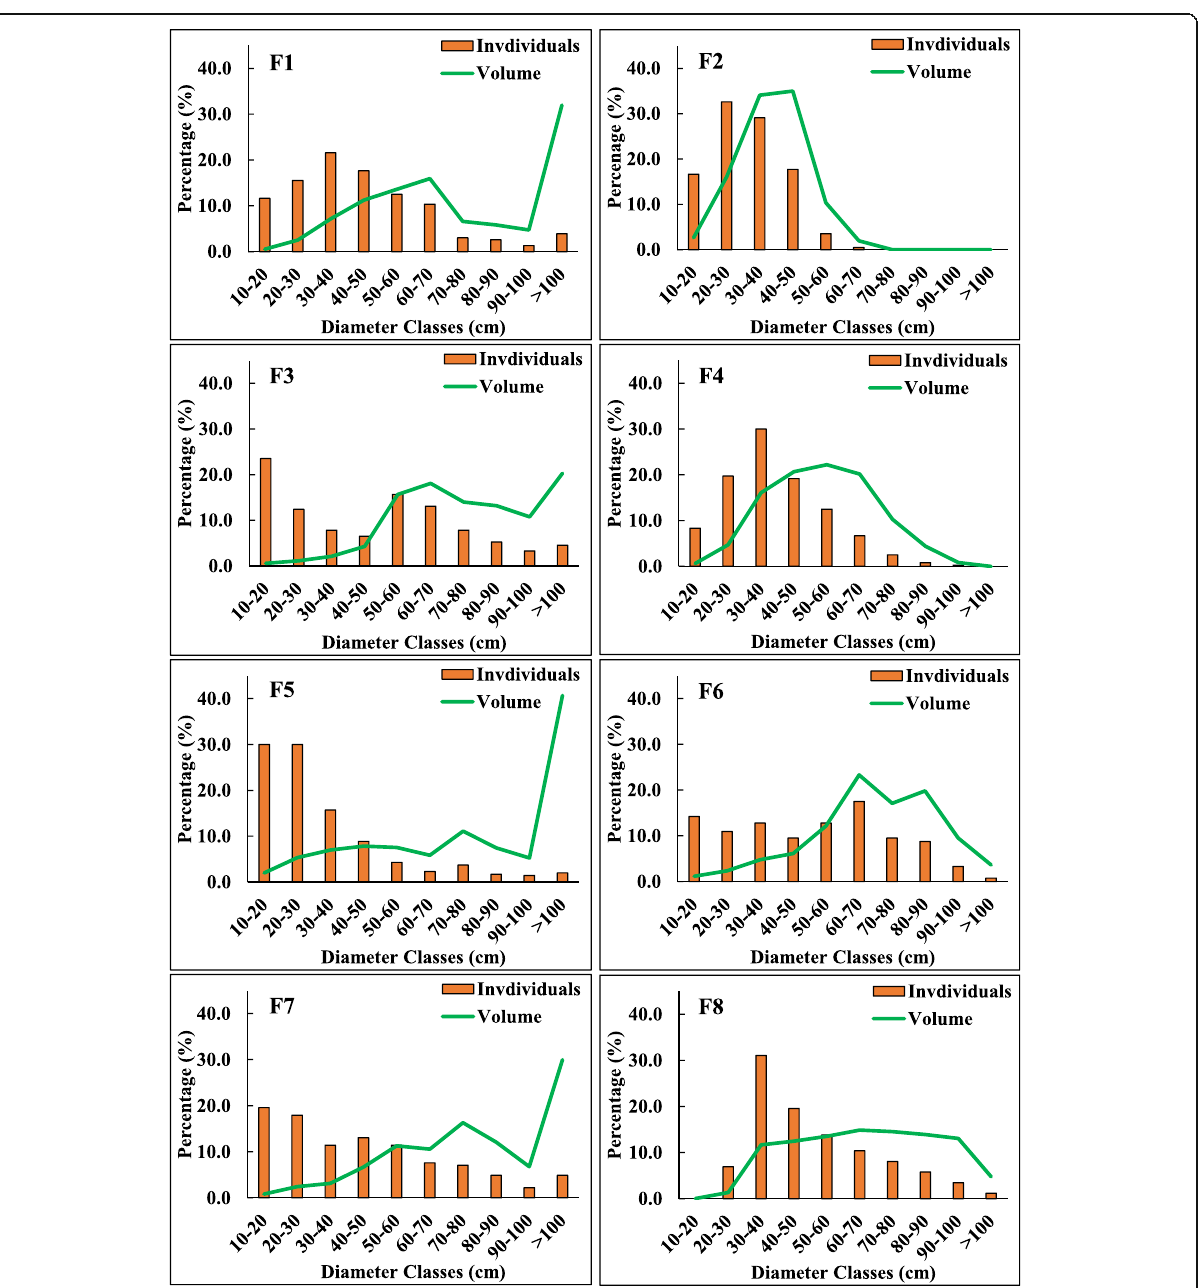
Fig. 2 Graphical distribution of tree density and growing stock volume corresponding to their diameter classes. F1 – F8 represents the study